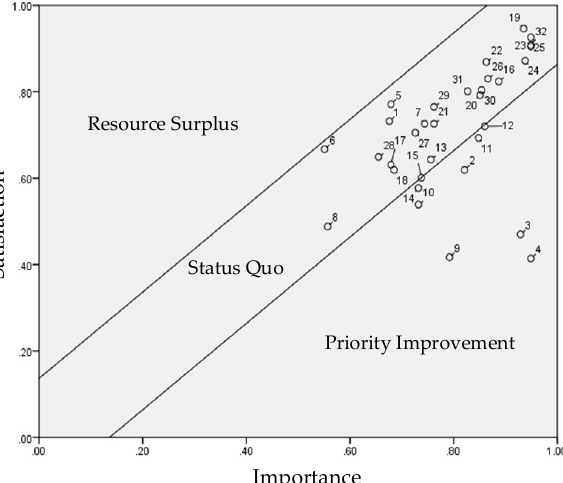
Figure 6. Performance Evaluation Matrix (PEM) of the Female Respondents. 4.5. PEM Analysis for Age We incorporated the importance and satisfaction values of respondents below and over the age of 70 as presented in Table 7 into Equations (1) and (2) to standardize the variables and include them in the PEM. We then defined the control lines (Table 8) to illustrate Figure 7. The items in need of improvement from the perspective of the male and female respondents were identified using Figures 7 and 8. Table 7. Performance Values of the Importance–Satisfaction Variables Based on Age . Construct